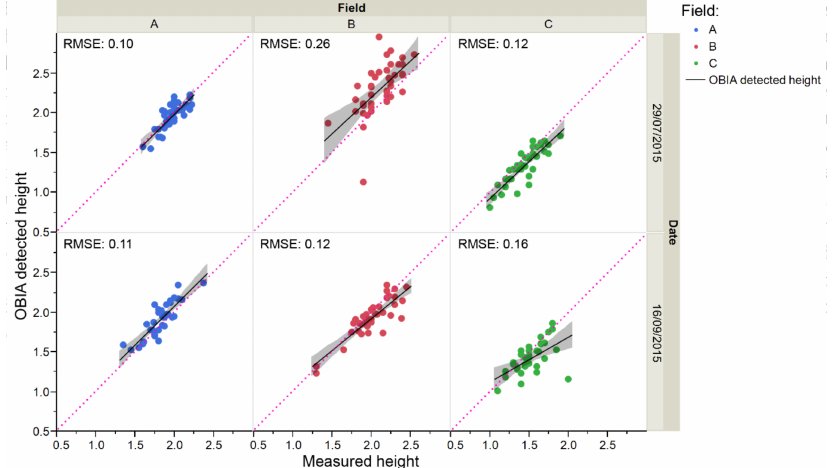
Figure 7. DSM-OBIA detected height vs. measured vine height divided by field and date. The root mean square error (RMSE) derived from the regression fit are included ( p < 0.0001). The solid line is the fitted linear function and the pink dashed lines represent the 1:1